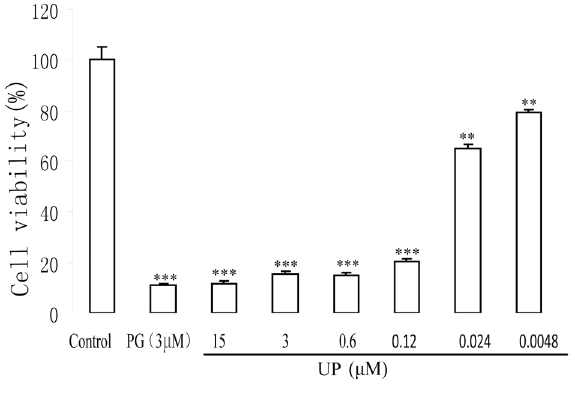
Figure 2. Effect of UP on the growth of P388 cells. Cells were treated with indicated concentration of UP and PG for 72 h. The data shown represent the percentages of cell viability of three independent experiments with three determinations in each. **, p , 0.01 and ***, p , 0.001 vs. Control.